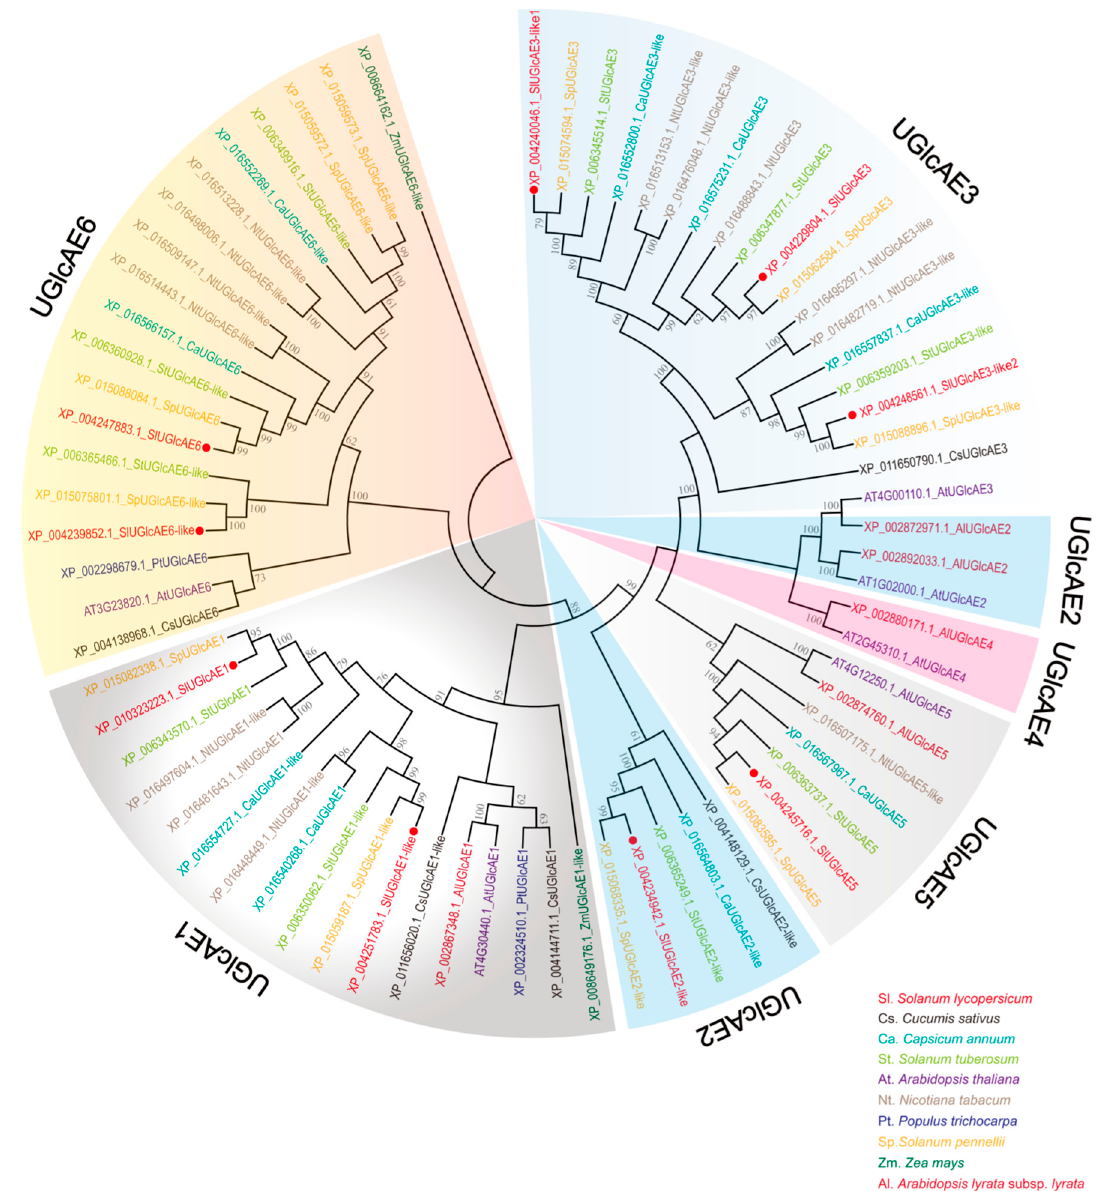
Figure 1. Phylogenetic analysis of the UGlcAE gene family based amino acids in tomato and other nine species. The unrooted neighbor-joining phylogenetic tree is generated by MEGA 5. The sequence names included three parts: the source numbers from NCBI, the abbreviation of species names, and their respective subfamilies. Red dots highlight the tomato UGlcAE